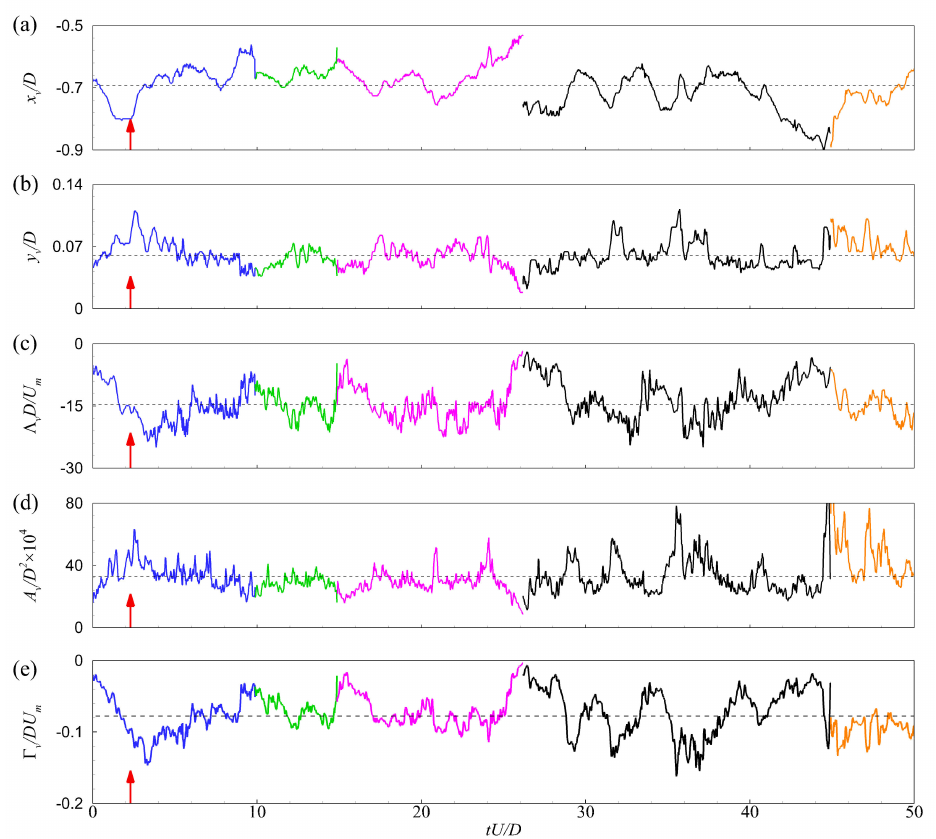
Figure 4. Time histories of ( a ) streamwise position, ( b ) vertical position, ( c ) coherence, ( d ) core area, and ( e ) circulation strength of several primary horseshoe vortices for case